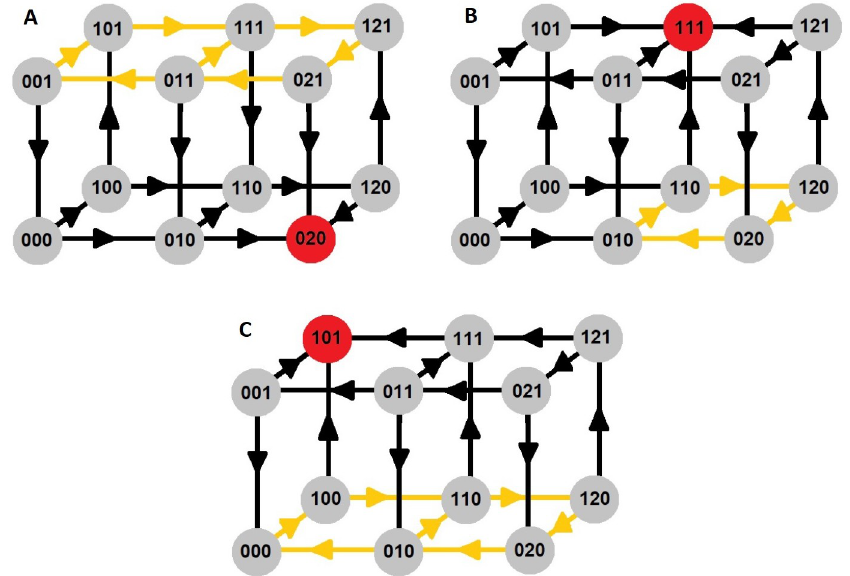
Fig 4. Transition graphs for different stress levels. A: R = 0 a.u.; B: R = 1.5 a.u.; C: R = 9 a.u. Red dot indicates RSP location, yellow arrows indicate closed sequences and by that possible limit cycle location. 0, 1 and 2 indicates if the given variable [P, N, T] is bellow (0) or above (1) its threshold. 2 indicates that N is above the second